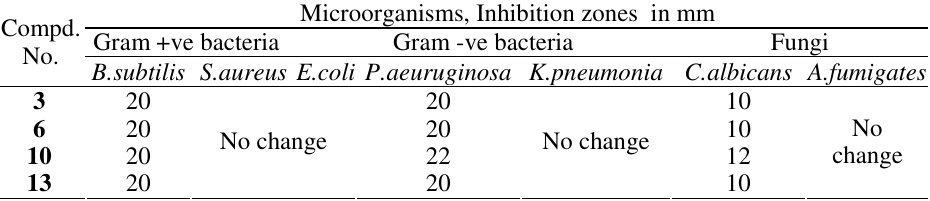
*Increasing in activity by using UV light (366